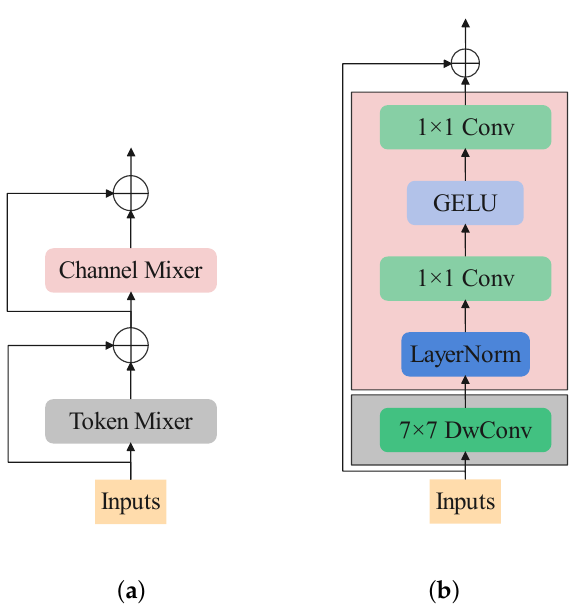
Figure 3. ( a ) The structure of MetaFormer block. ( b ) The structure of ConvNeXt